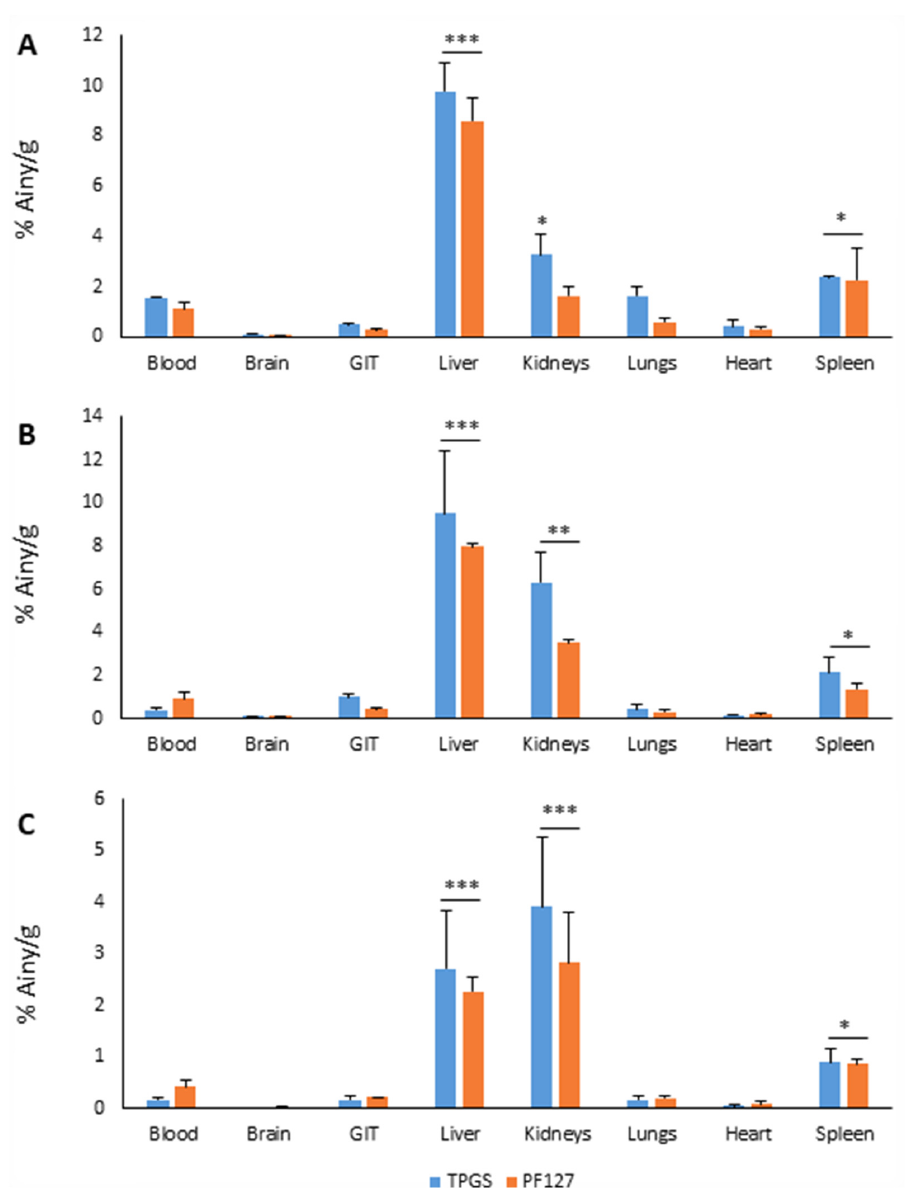
Figure 5. Biodistribution of TPGS (blue) and PF127 (orange) micelles in different organs at 30 min ( A ), 3 h ( B ), and 24 h ( C ) after their intravenous injection. GIT: gastrointestinal tissue. n = 3. * p < 0.05; ** p < 0.01; *** p < 0.001, all versus blood.